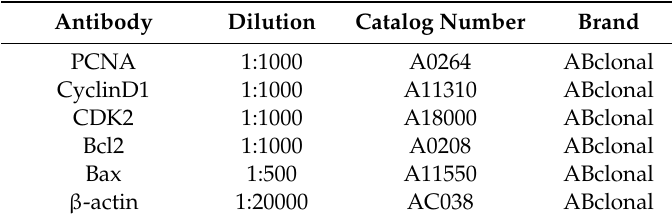
Table 2. The information of antibodies used for western blot.